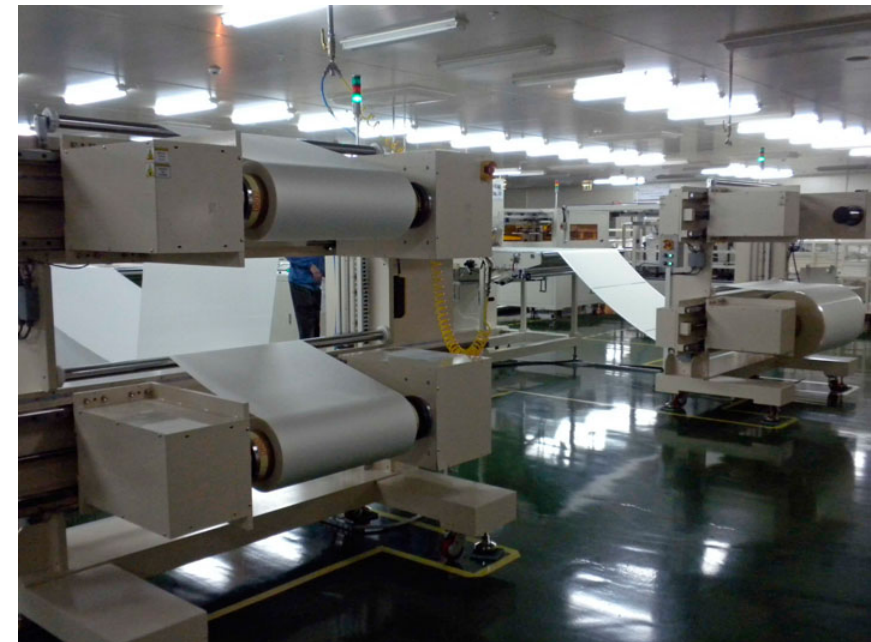
Fig. 8. General view of position of presses